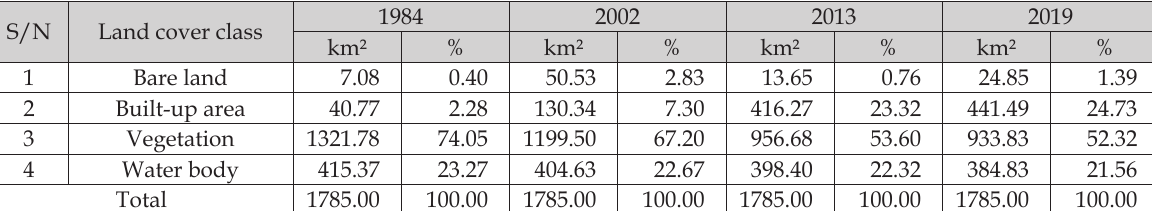
Table 4. Areal distribution of land cover in 1984, 2002, 2013 and 2019.